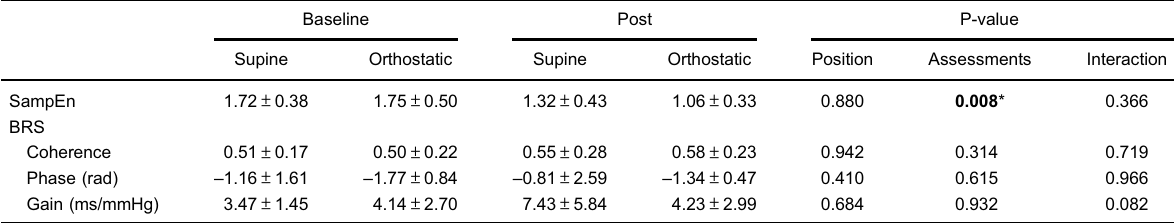
Table 3. SampEn and barore fl ex sensitivity (BRS) in control group. Baseline